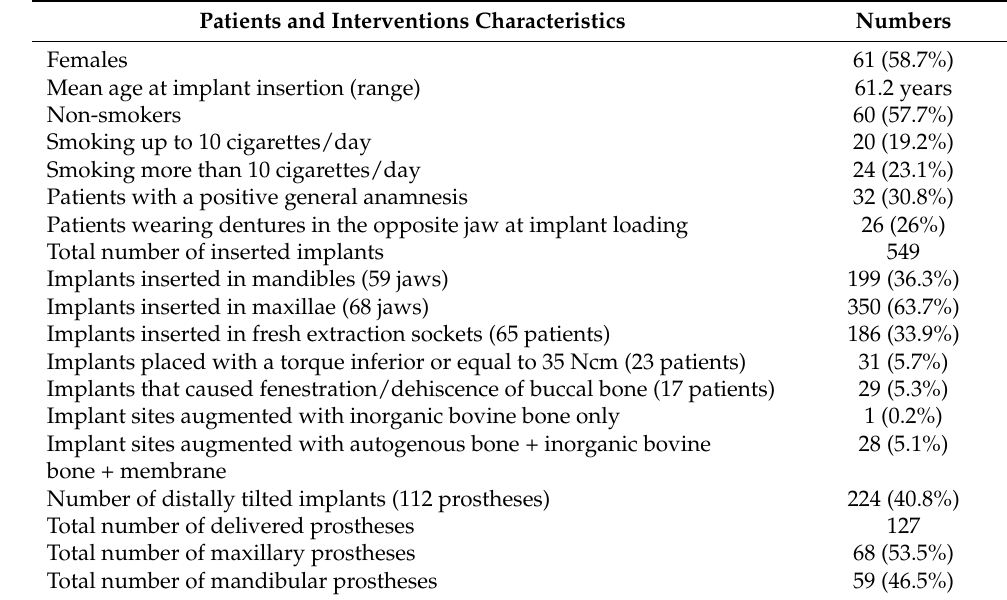
Table 2. Patients and interventions characteristics (104